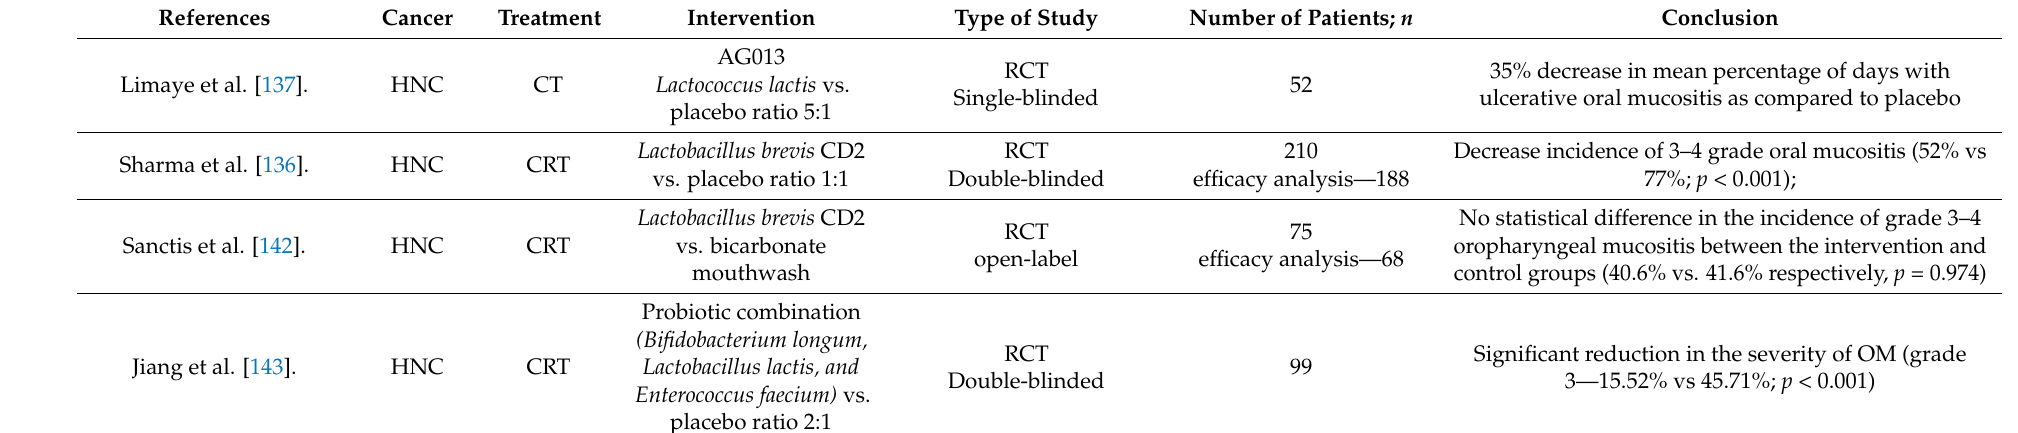
HNC—head and neck cancer; RT—radiotherapy; CT—chemotherapy; CRT—chemoradiotherapy, RCT—randomised clinical